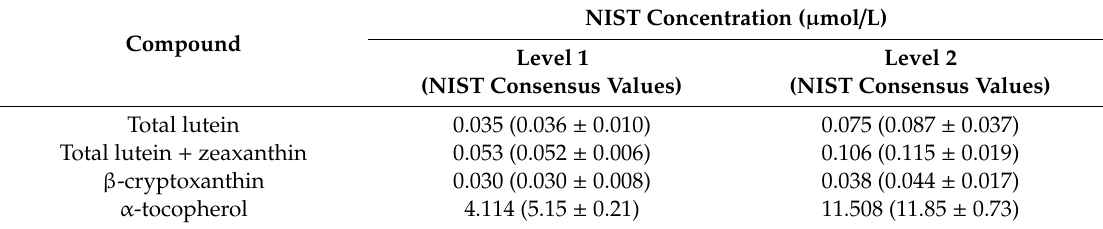
Table A8. Trueness of xanthophyll carotenoid